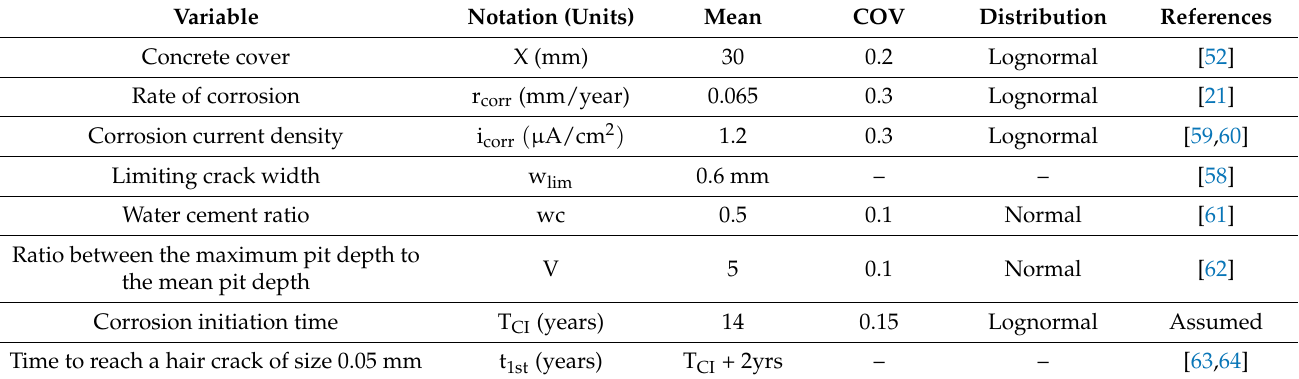
Table 11. Values and probabilistic descriptors of parameters used in Equations (A2) and (A3). Variable